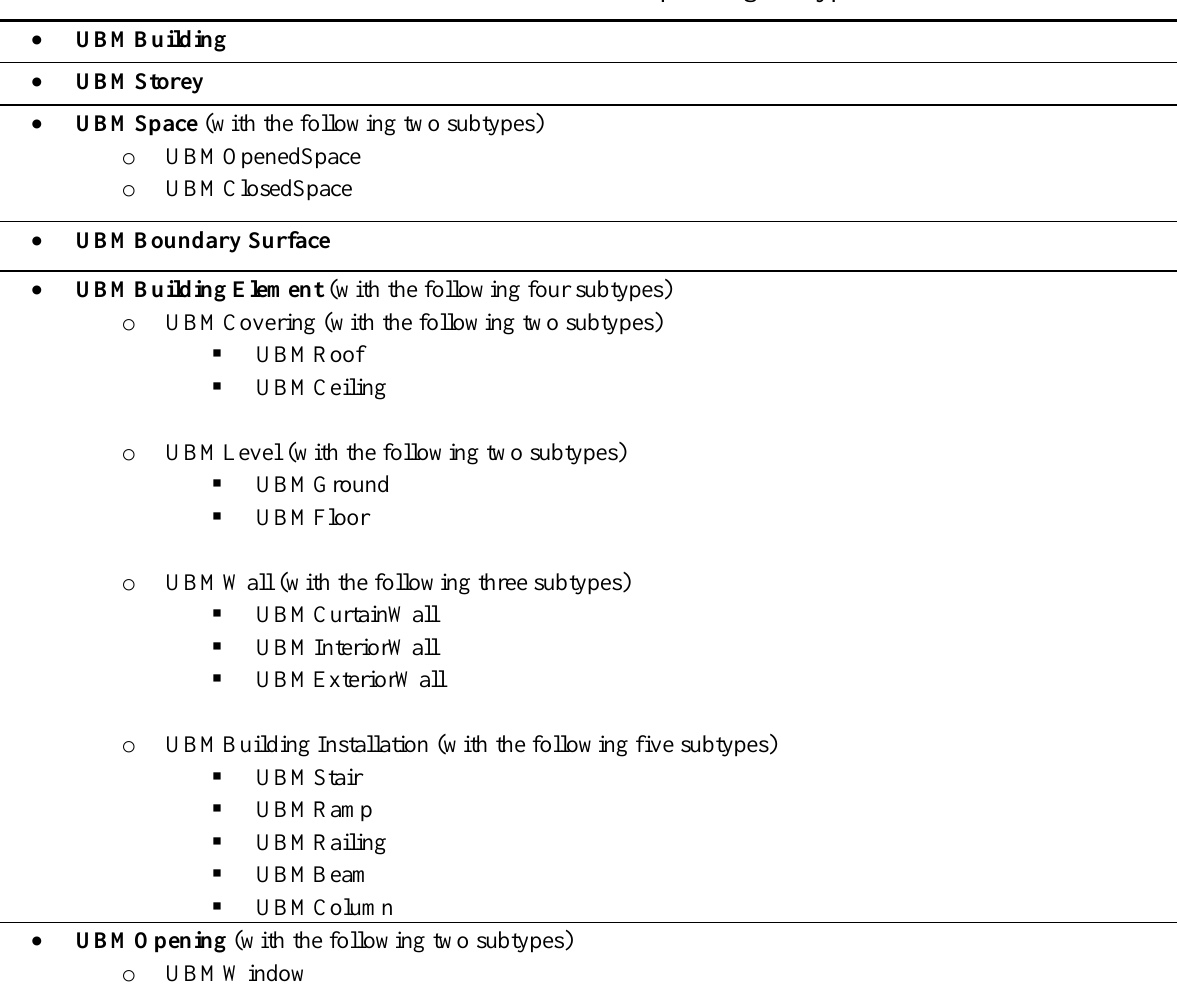
Table 1. Feature classes with corresponding